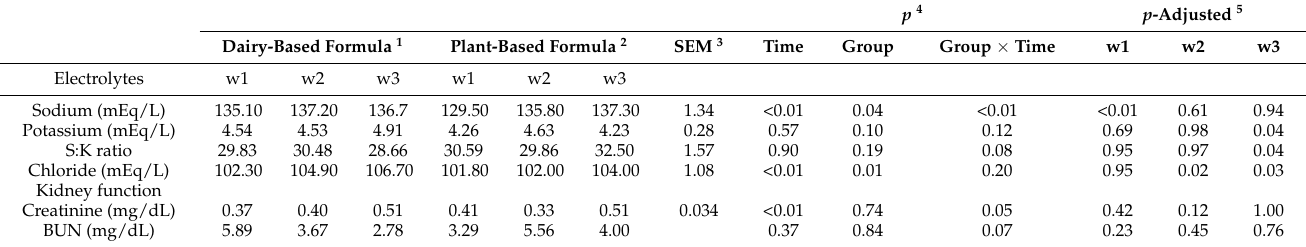
Table 4. Group average per week of age (w1, w2, w3) of kidney function biomarkers and electrolytes measured in the plasma of piglets fed either a dairy-based or a plant-based formula ( n = 9/group) from postnatal day (PND) 2 until PND 21. p 4 p -Adjusted